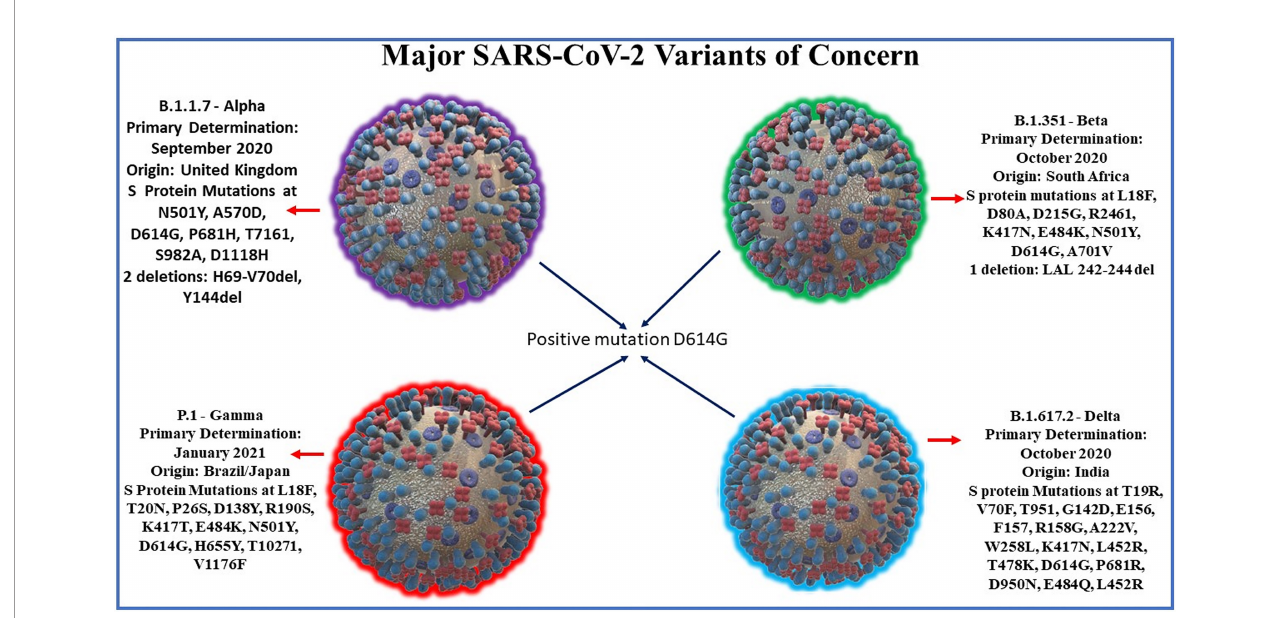
FIGURE 1 | Major SARS-CoV-2 variants along with their dates and location of primary determination and their characteristic spike protein mutation sites. SARS- CoV-2 variants share a common mutation in D614G of the spike protein. Notable spike mutations: Alpha variant mutations include N501Y, an asparagine to tyrosine amino acid substitution at position 501, and P681H, a proline to histidine substitution at position 681have been found to be preserved in subsequent variants. The Beta variant E484K mutation, glutamate to lysine substitution at position 484 of the RBD arising from South Africa may lead to possible gain-of-function ability to confer advantage against current convalescent plasma treatments. Beta & Gamma (Brazil/Japan) lineage mutations also include K417N and N501Y and may together lead to possible gain-of-function escape from neutralizing antibodies. Delta variant, fi rst discovered in India 2020, mutations include L452R substitution correlates with higher af fi nity to the ACE2 host receptor, & P681R may be responsible for increased infectivity of host